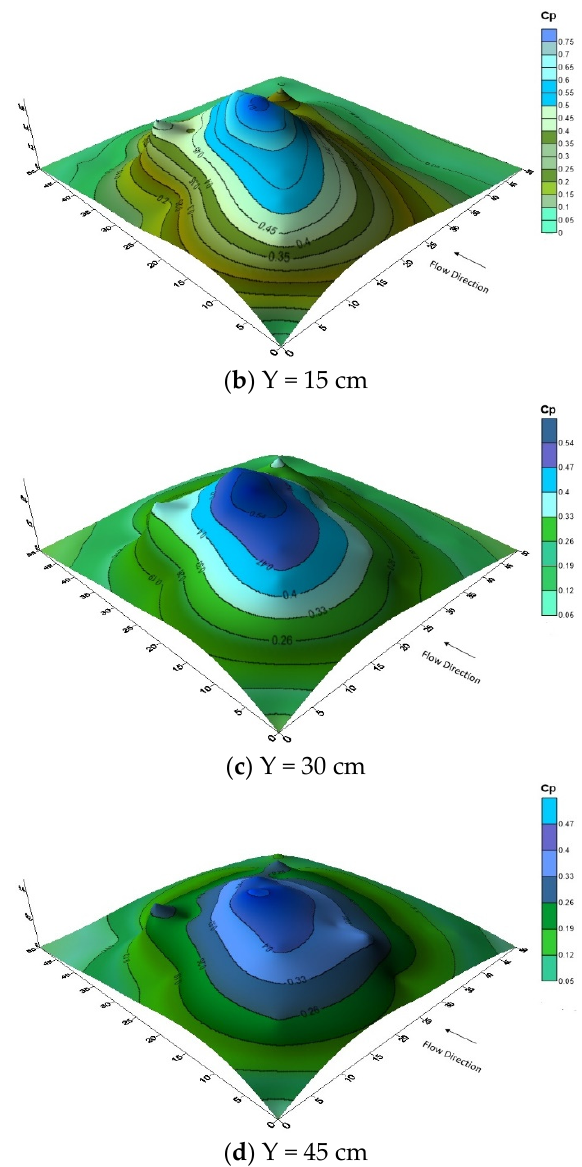
Figure 7. Variations of mean dynamic pressure coefficient at radial distances from falling jet axis for discharge 184 L/s at 0° in plunging depths of ( a ) 0; ( b ) 15 cm; ( c ) 30; and ( d ) 45 cm.